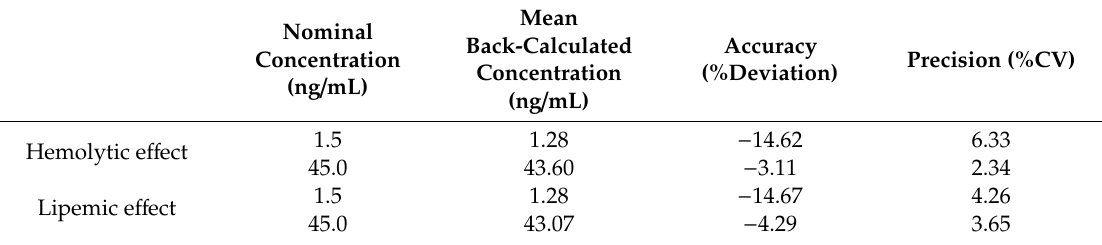
Table 4. Hemolytic and lipemic e ff ects of sumatriptan in hemolyzed and hyperlipidemic human plasma, respectively ( n = 6).